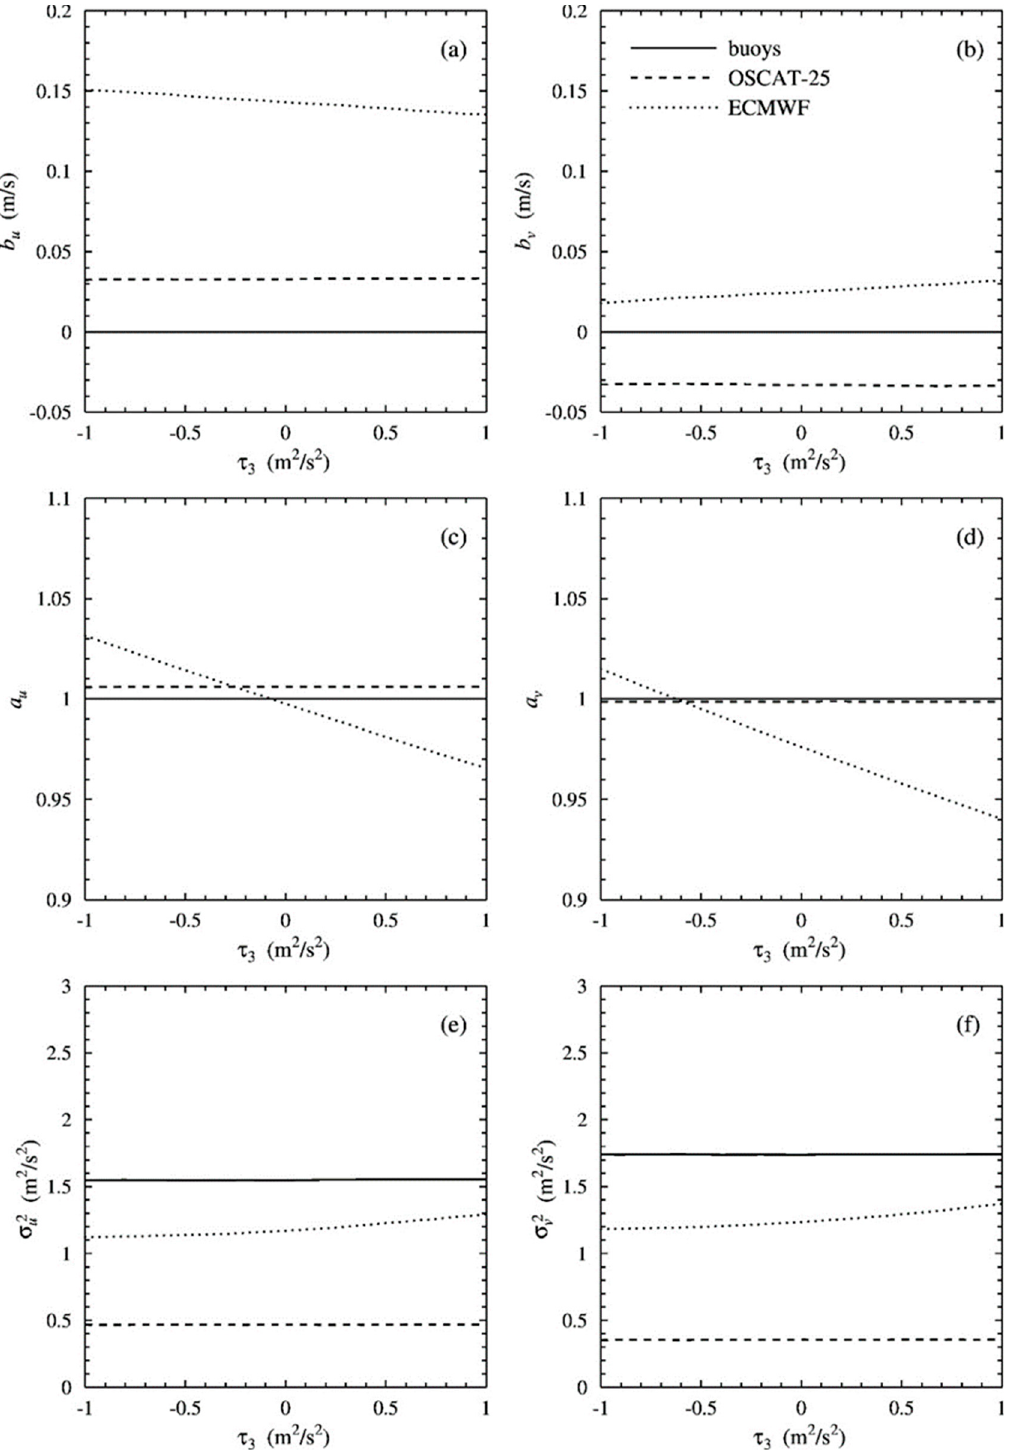
Figure 3. As Figure 1, but for error non-orthogonality 𝜏 (cid:2871) in the ECMWF forecasts (system 3).